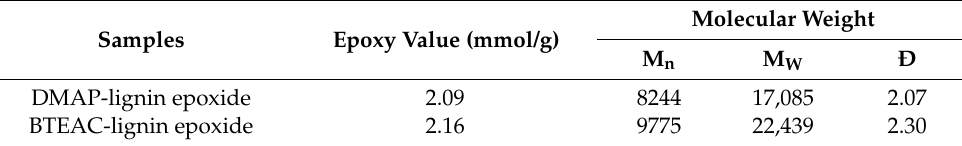
Table 5. The epoxy value, molecular weight, and Ɖ of the lignin epoxides.